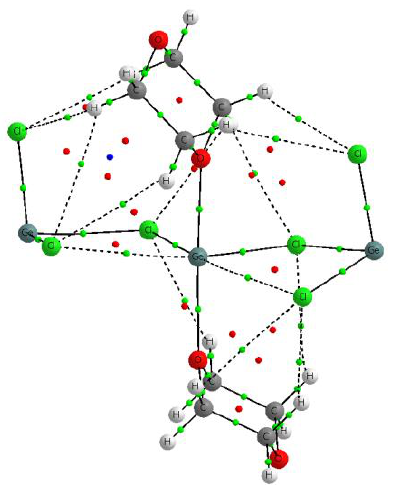
Figure 7. The molecular graph of (GeBr 2 ) 3 -(C 4 H 8 O 2 ) 2 ; big circles correspond to the attractors (red— oxygen, green — chlorine, grey — germanium, white — hydrogen), small green circles to the bond critical points and red circles to the ring critical points; solid and broken lines indicate bond paths.